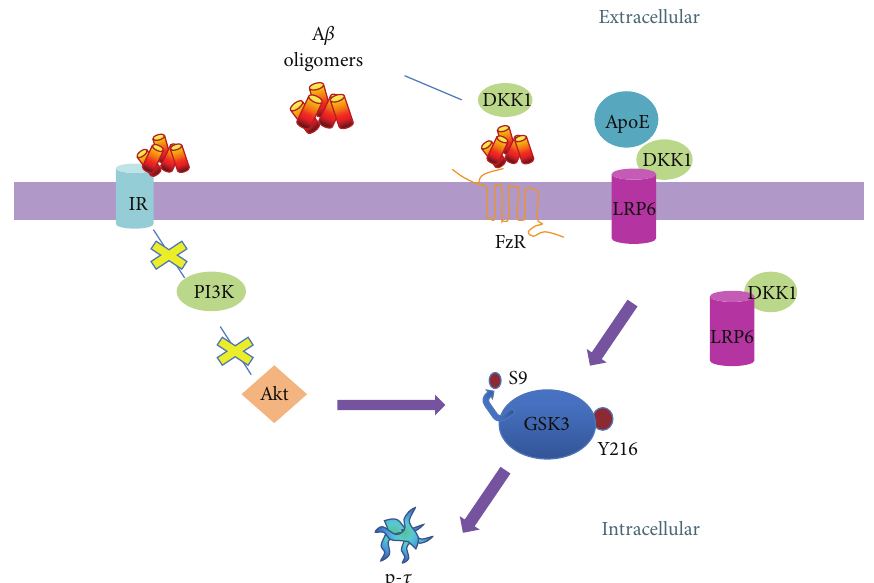
Figure 4: Proposed model of GSK3 activation by amyloid- β protein in AD. Amyloid- β oligomers bind to the insulin receptor and inhibit PI3K/Akt pathway, and Akt is unable to phosphorylate and inactivate GSK3. A β also induces the expression of DKK1, which internalizes LRP6 receptor and inhibits Wnt signaling leading to GSK3 activation. A β can bind to Frizzled receptor (FzR) and inactivate Wnt signaling as well. ApoE also inhibits this signaling pathway and activates GSK3. Tau hyperphosphorylation and NFT formation may result from GSK3